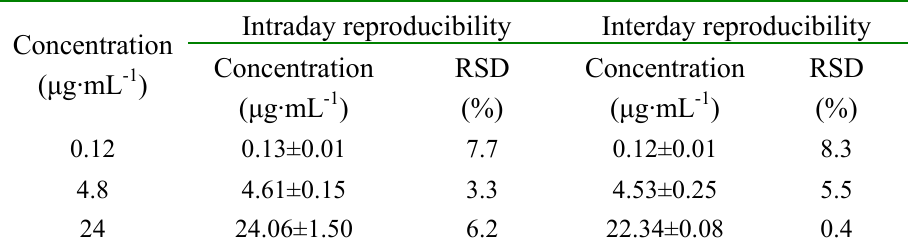
Table 5. Intraday and Interday Reproducibility of Caffeine (mean ±SD,